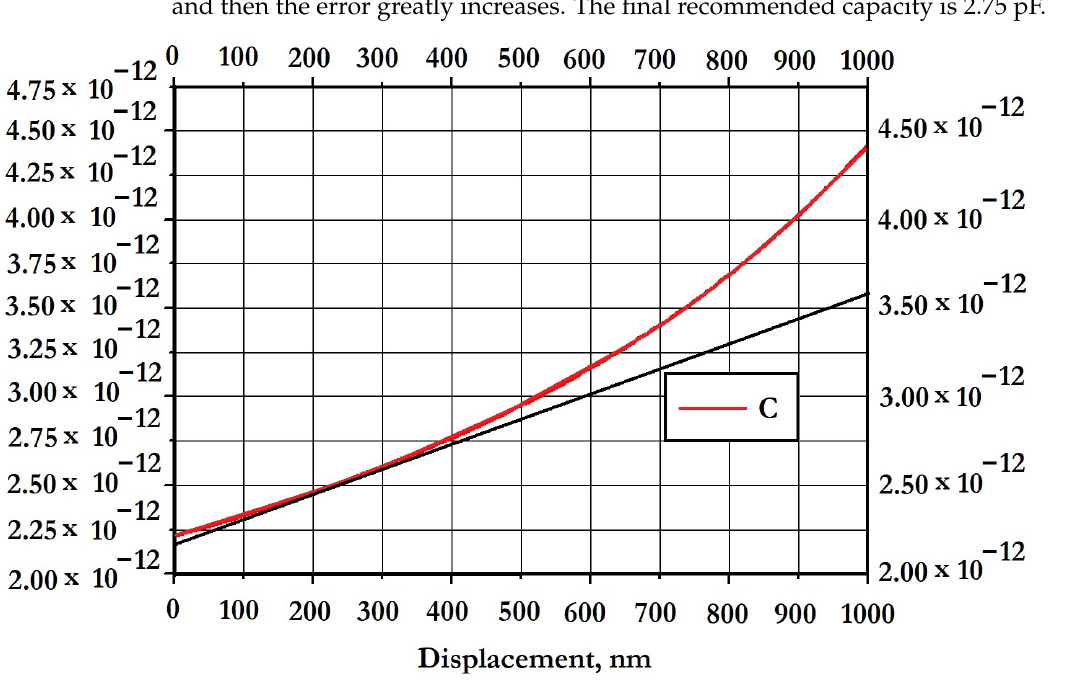
Figure 7. Graph of capacitance changes when the gap between the fingers decreases. When the tanks are switched on in differential mode, the value for the tanks doubles. With a deviation of 0.4 µ m, the capacitance increases by 0.55 pF. The final parameters of the capacitive converter are given in Table